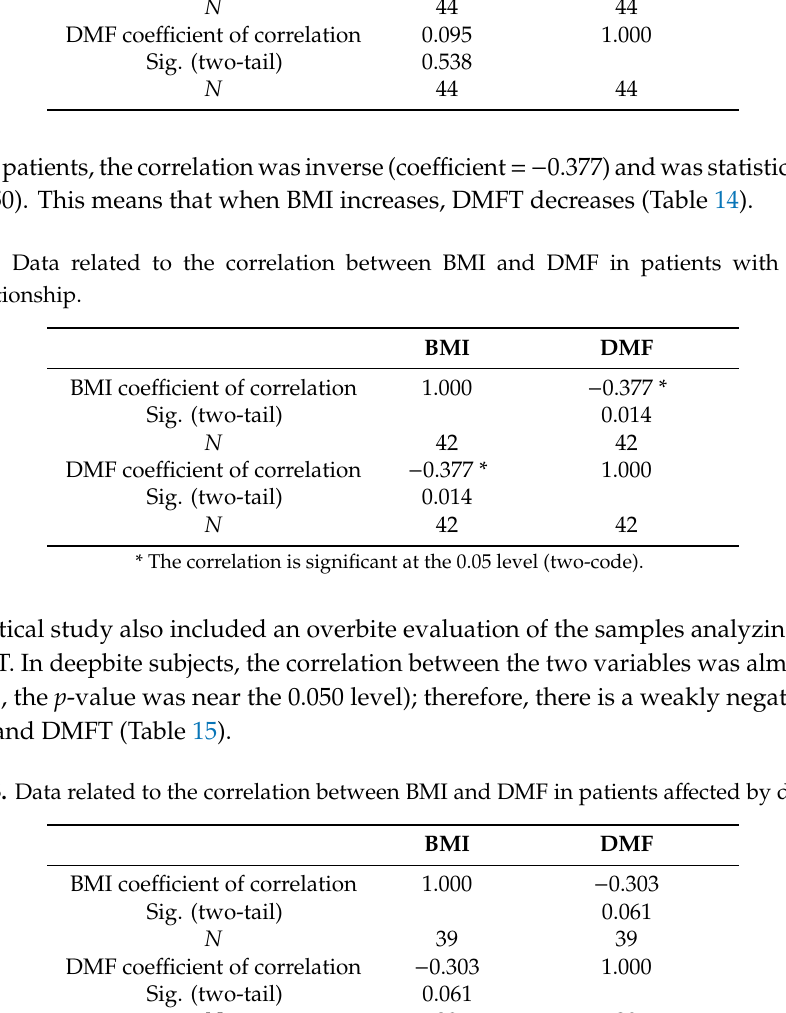
Table 13. Data related to the correlation between BMI and DMF in patients with a Class III molar relationship. BMI DMF BMI coe ffi cient of correlation Sig. (two-tail)